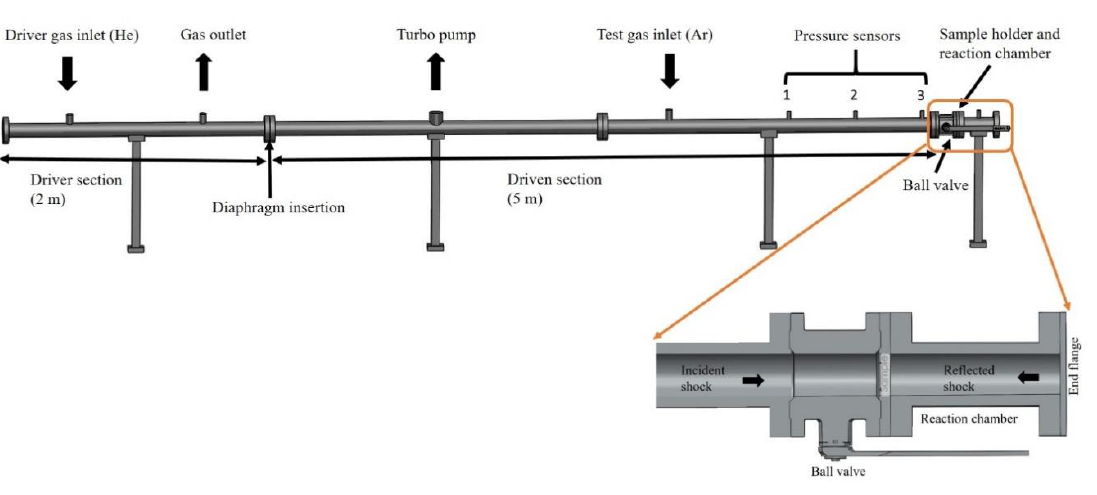
Figure 7. Schematic diagram of Material Shock Tube (MST1).